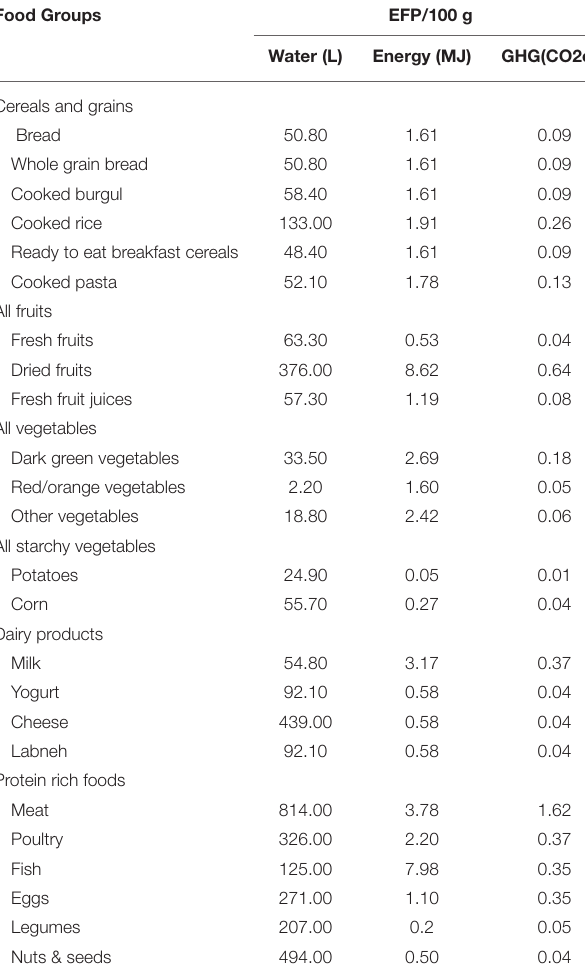
TABLE 4 | EFP (Water, Energy, and GHG) per 100g for each food group used in the